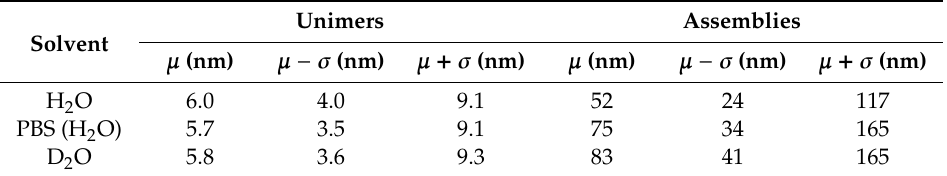
Table 2. Results of the normal distribution fit of peaks corresponding to unimers (U) and assemblies (A) in H 2 O, PBS and D 2 O describing the width of the individual population peaks with regard to their means µ